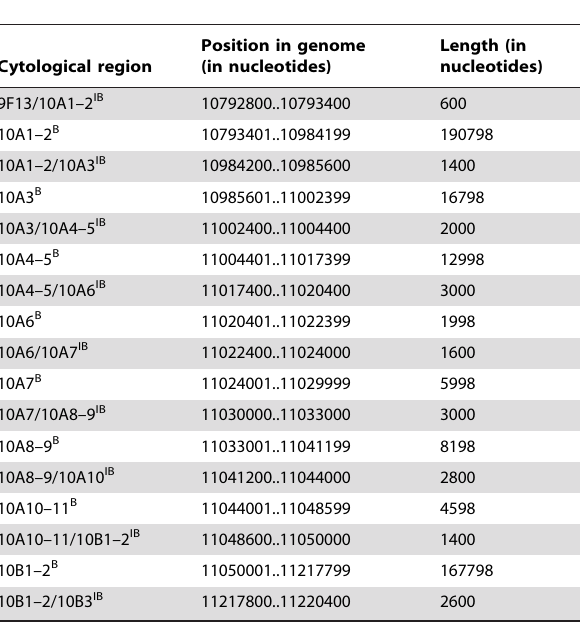
Table 1. Coordinates and sizes of bands and interbands on physical map of the 9F13 – 10B3 region.